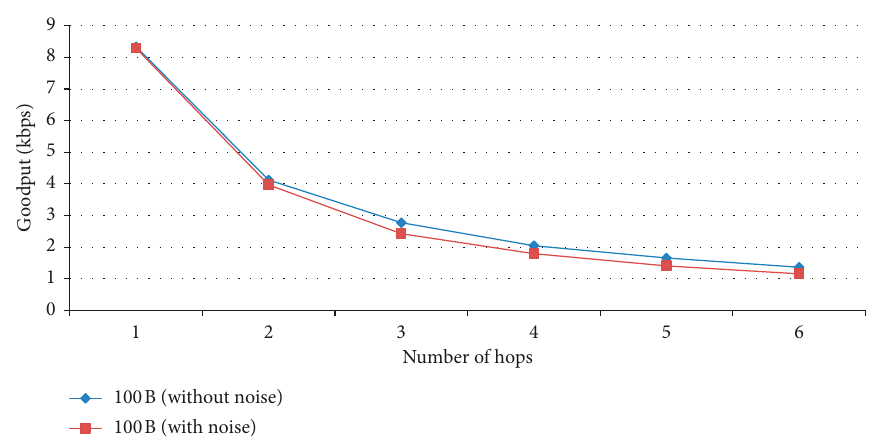
Figure 10: Goodput performance as a function of the number of hops.